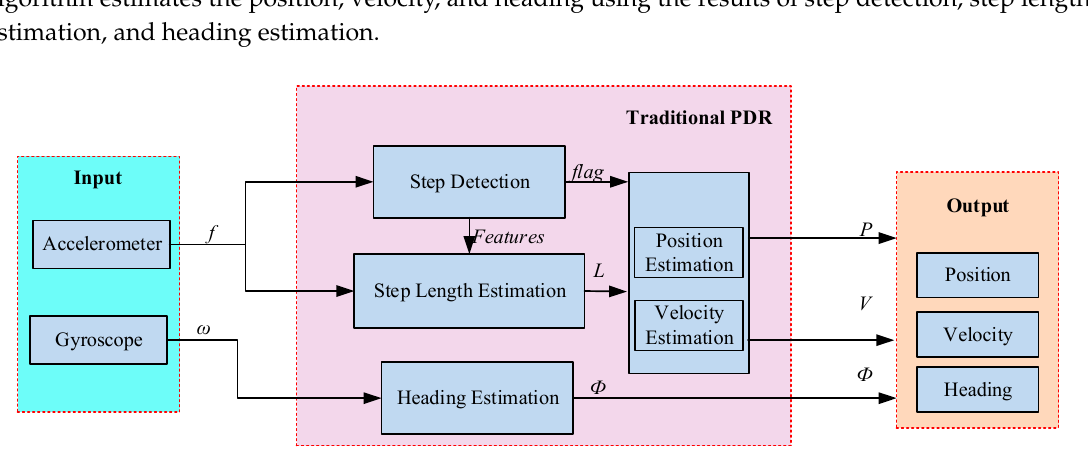
Figure 1. Scheme of traditional pedestrian dead reckoning (PDR) algorithm.